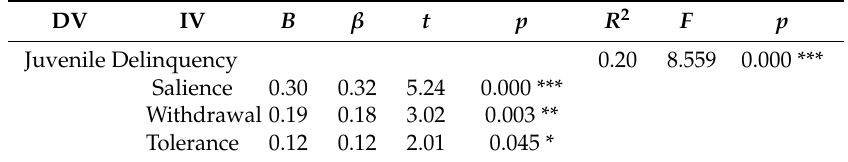
Table 2. Results of multiple regression: effects of online game addiction on juvenile delinquency.